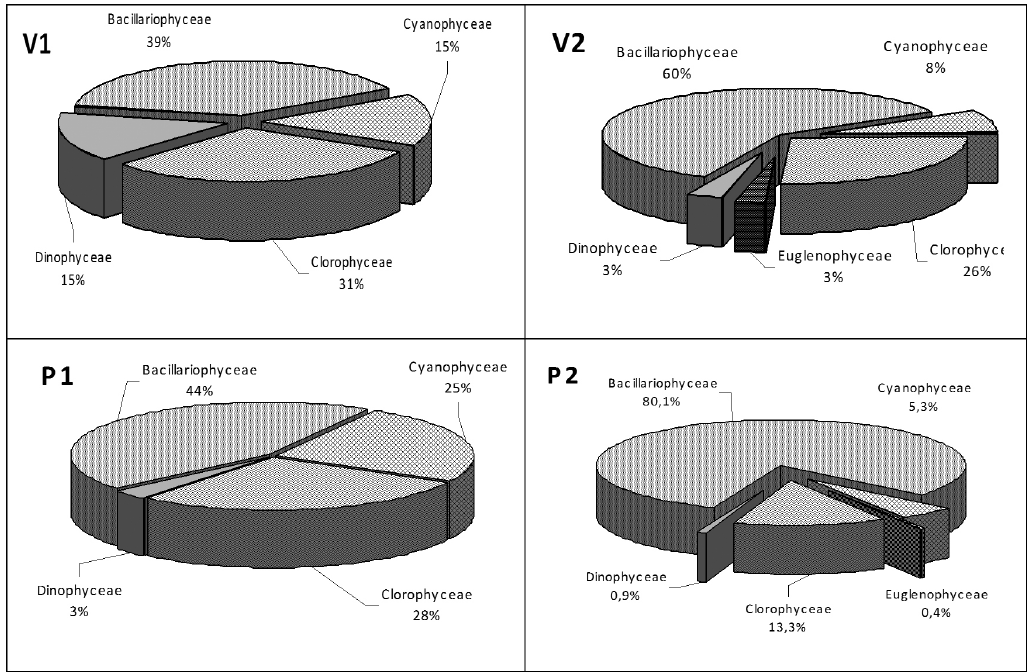
Figure 2. Relative abundance of different class of algae at the sampling sites in the Bebedero Basin (San Luis). V Volcán River, V Cuchi Corral River, P 2